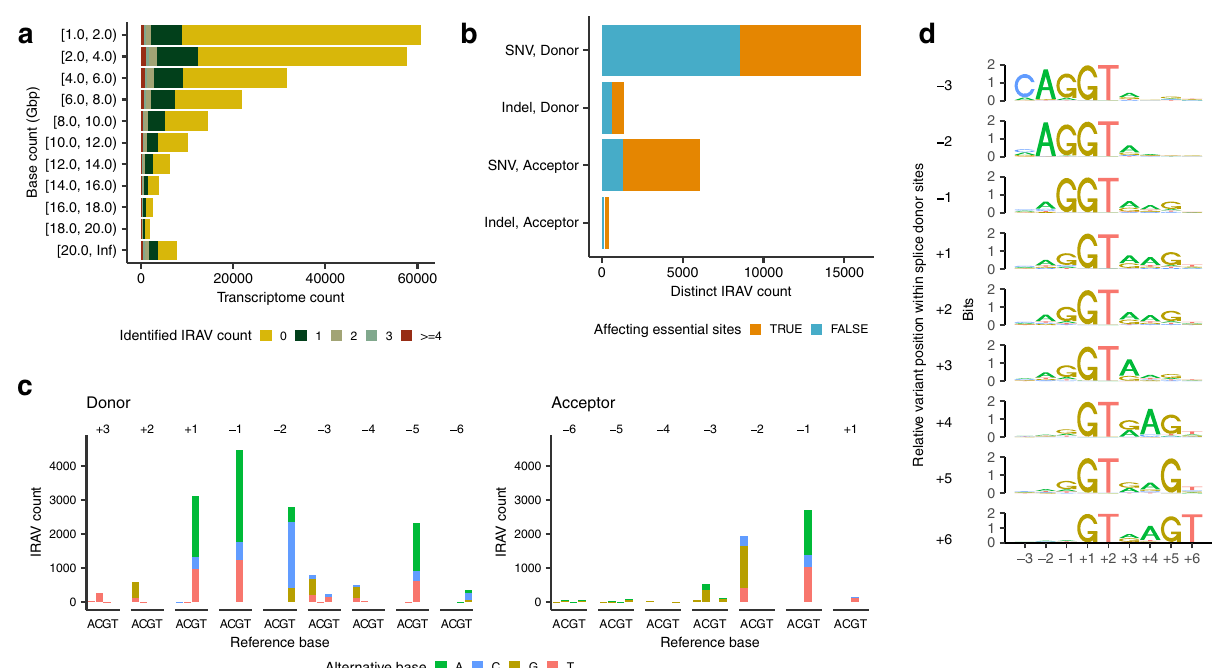
Fig. 3 | Overviews of IRAVs identi fi ed from Sequencing Read Archive. a Frequenciesoftranscriptomesequencingdataanalyzedbinnedbytheamountof base counts. Transcriptome data were also grouped by the number of detected IRAVs. For example, in the rows [1.0, 2.0), zero, one, two, three, and four or more IRAVswereidenti fi edin 51,793, 6,600, 1,187, 419, and 659 transcriptome sequence data, respectively, whose base count are ≥ 1.0 Gbp and <2.0 Gbp. b The number of distinct IRAVs affecting or not affecting essential splice-site (GT-AG), strati fi ed by